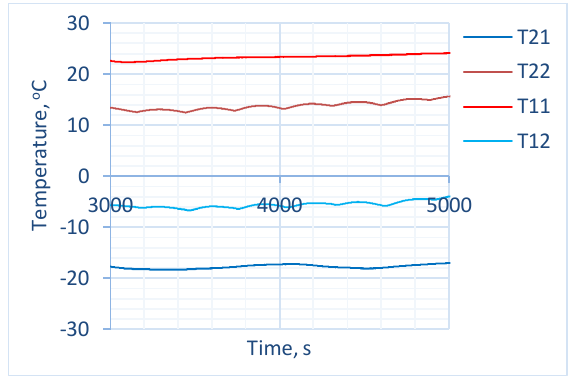
Fig. 3. Fresh t 21 , supply t 22 , exhaust t 11 and waste t 12 air temperature changes.